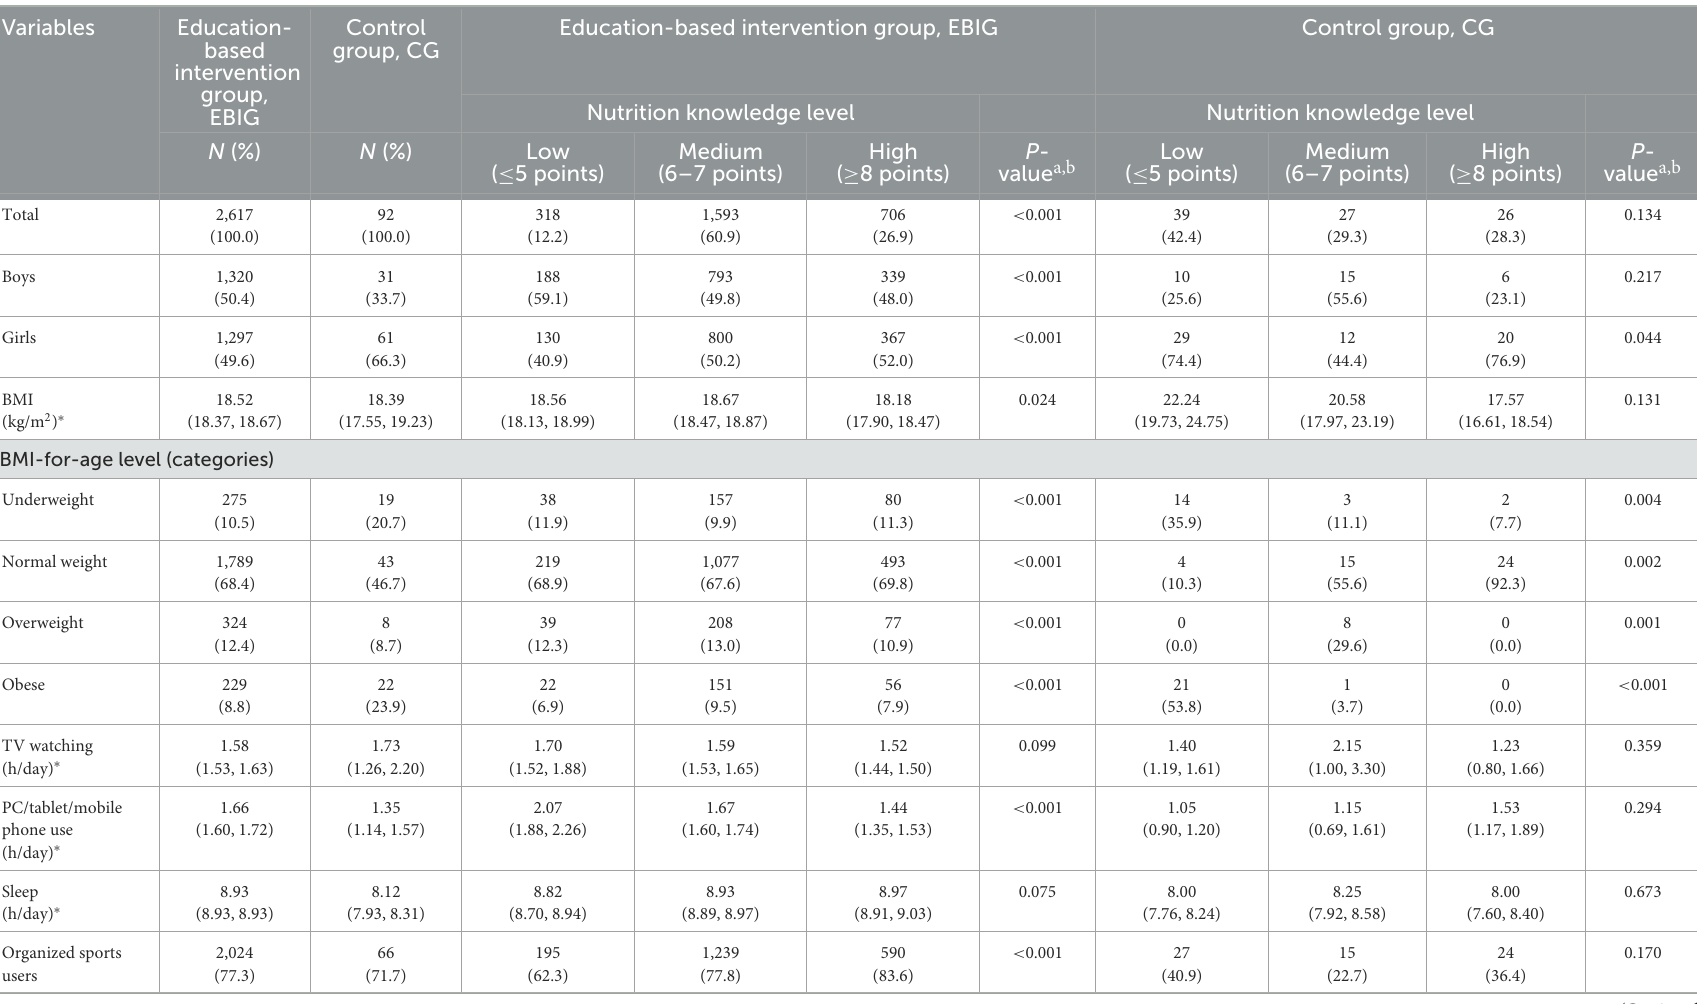
TABLE 1 The characteristics, lifestyle habits and nutrition knowledge of 2,709 school children according to the baseline nutrition knowledge level [ N (%) or mean (95% confidence interval)] ∗ .